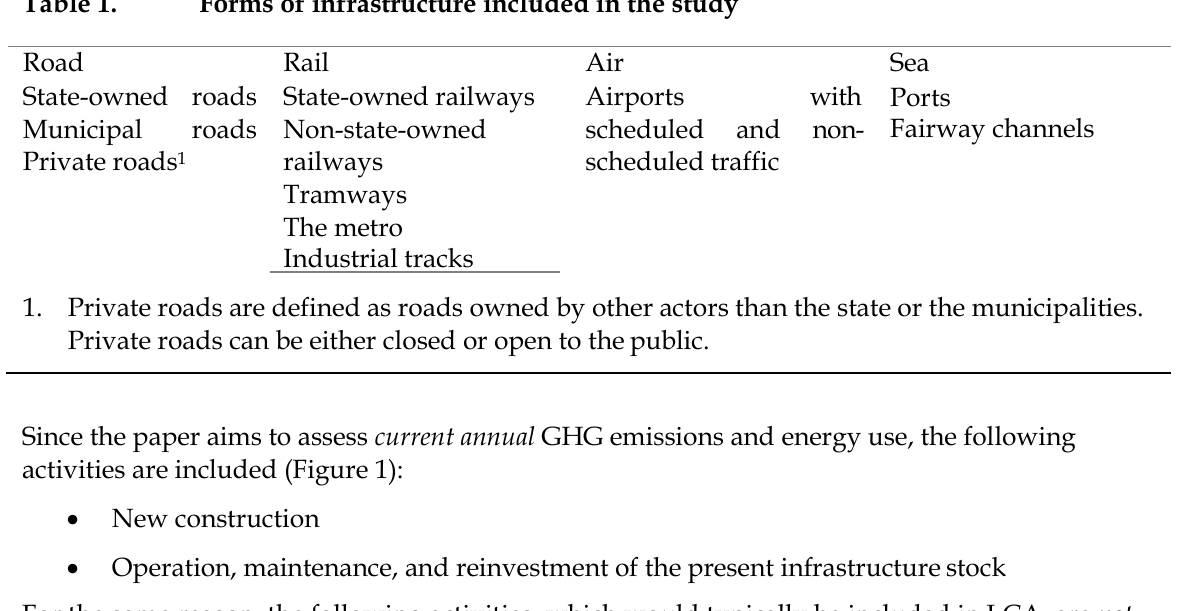
Airports with scheduled and non- scheduled traffic